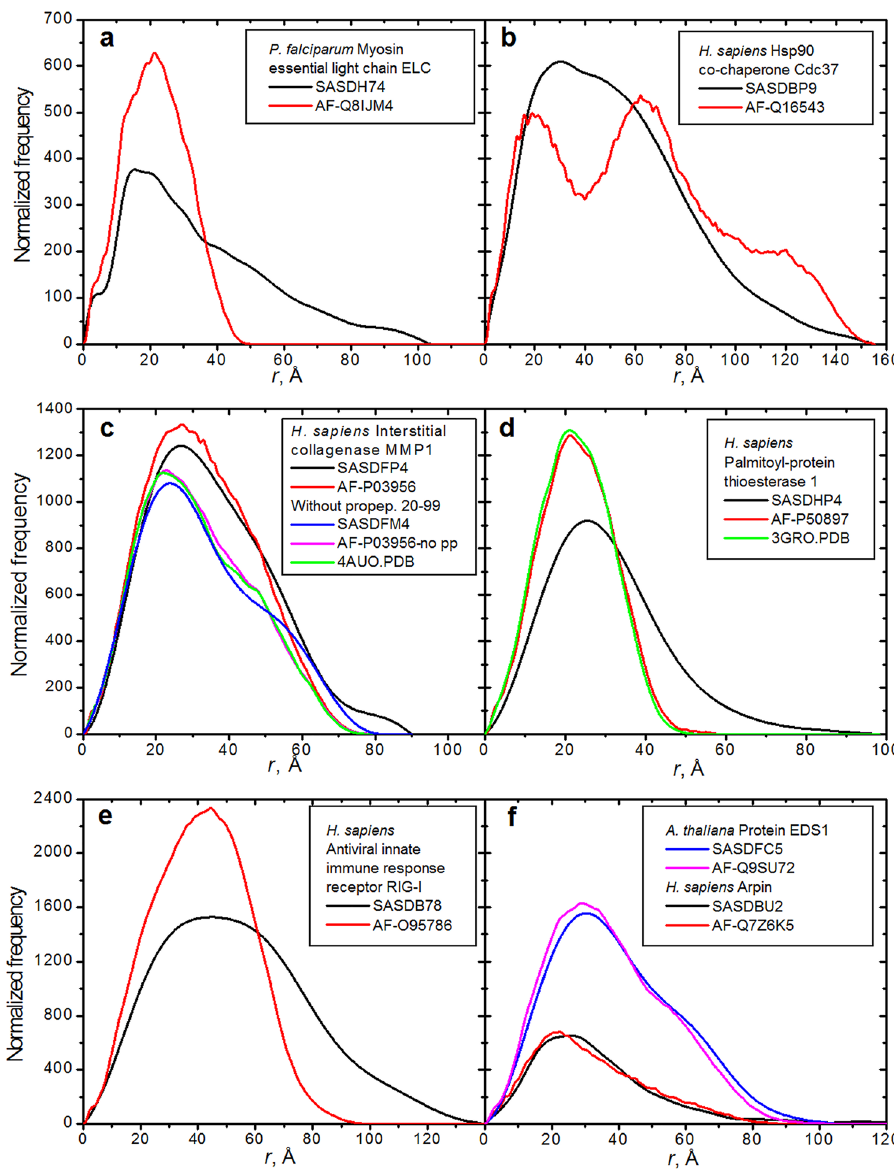
Figure 4. P ( r ) vs. r curves SAXS-derived and calculated from AF and RCSB PDB structures. ( a – f ) Protein source and names, SASBDB, AF (UniProt) and RCSB PDB accession numbers for each entry are indicated in the boxes within each panel. In all panels the experimentally-derived and the AF-calculated p ( r ) vs. r are black and red lines, respectively. Additional SAXS-derived and AF-calculated p ( r ) vs. r present in ( c,f ) are blue and magenta lines, respectively. Additional PDB-calculated p(r ) vs. r (green lines) are present in ( c,d